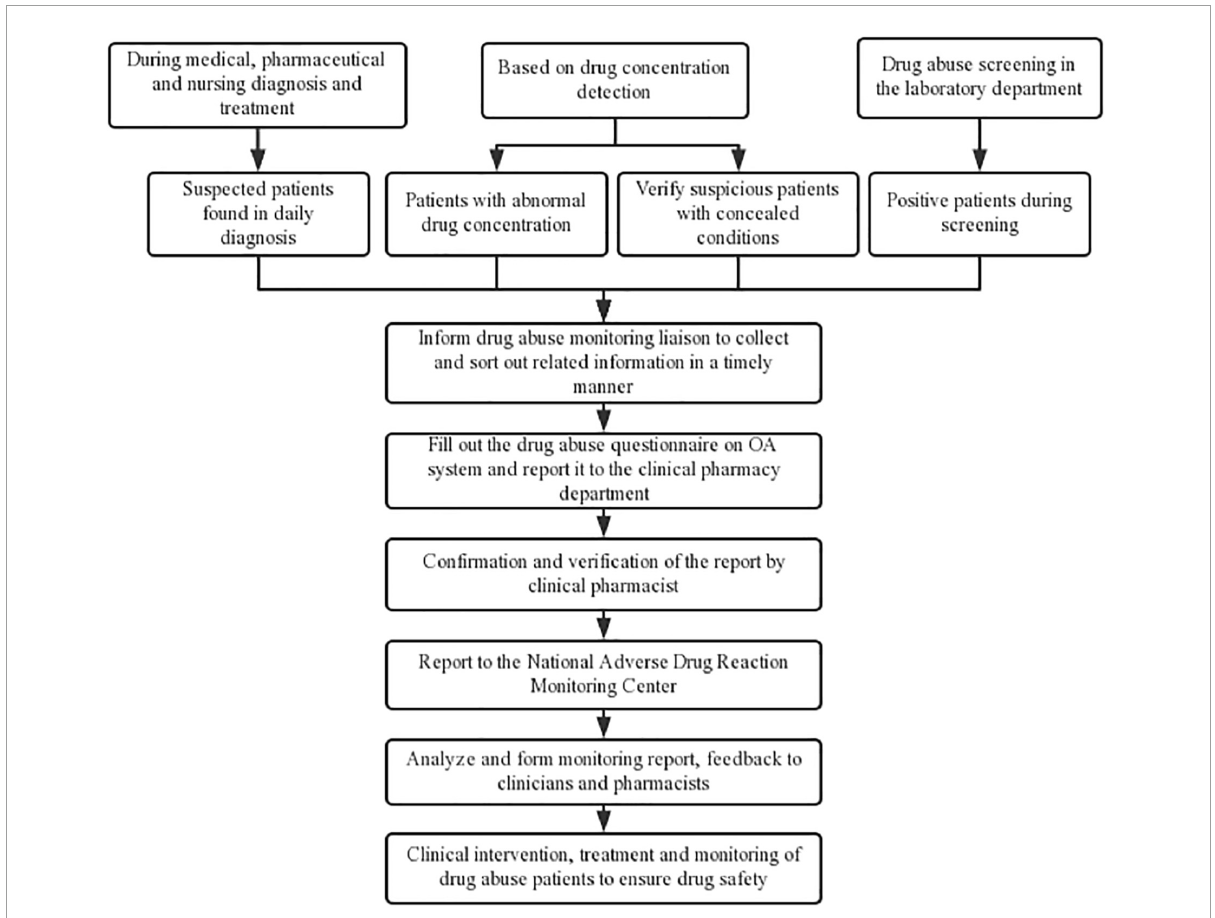
FIGURE1 Details of the active real-time PMA monitoring